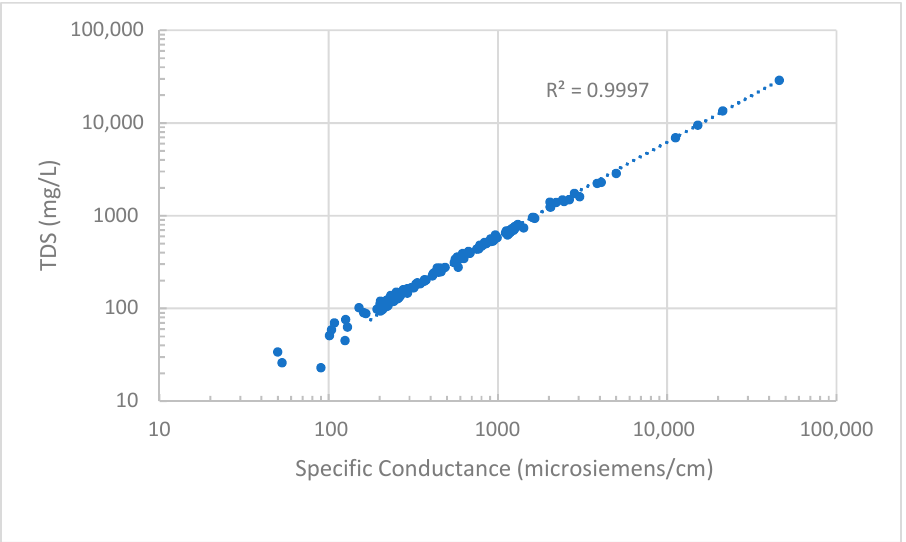
Figure 4. Relation between specific conductance and TDS in groundwater. Samples collected from central Florida (after Adamski and German, 2004).